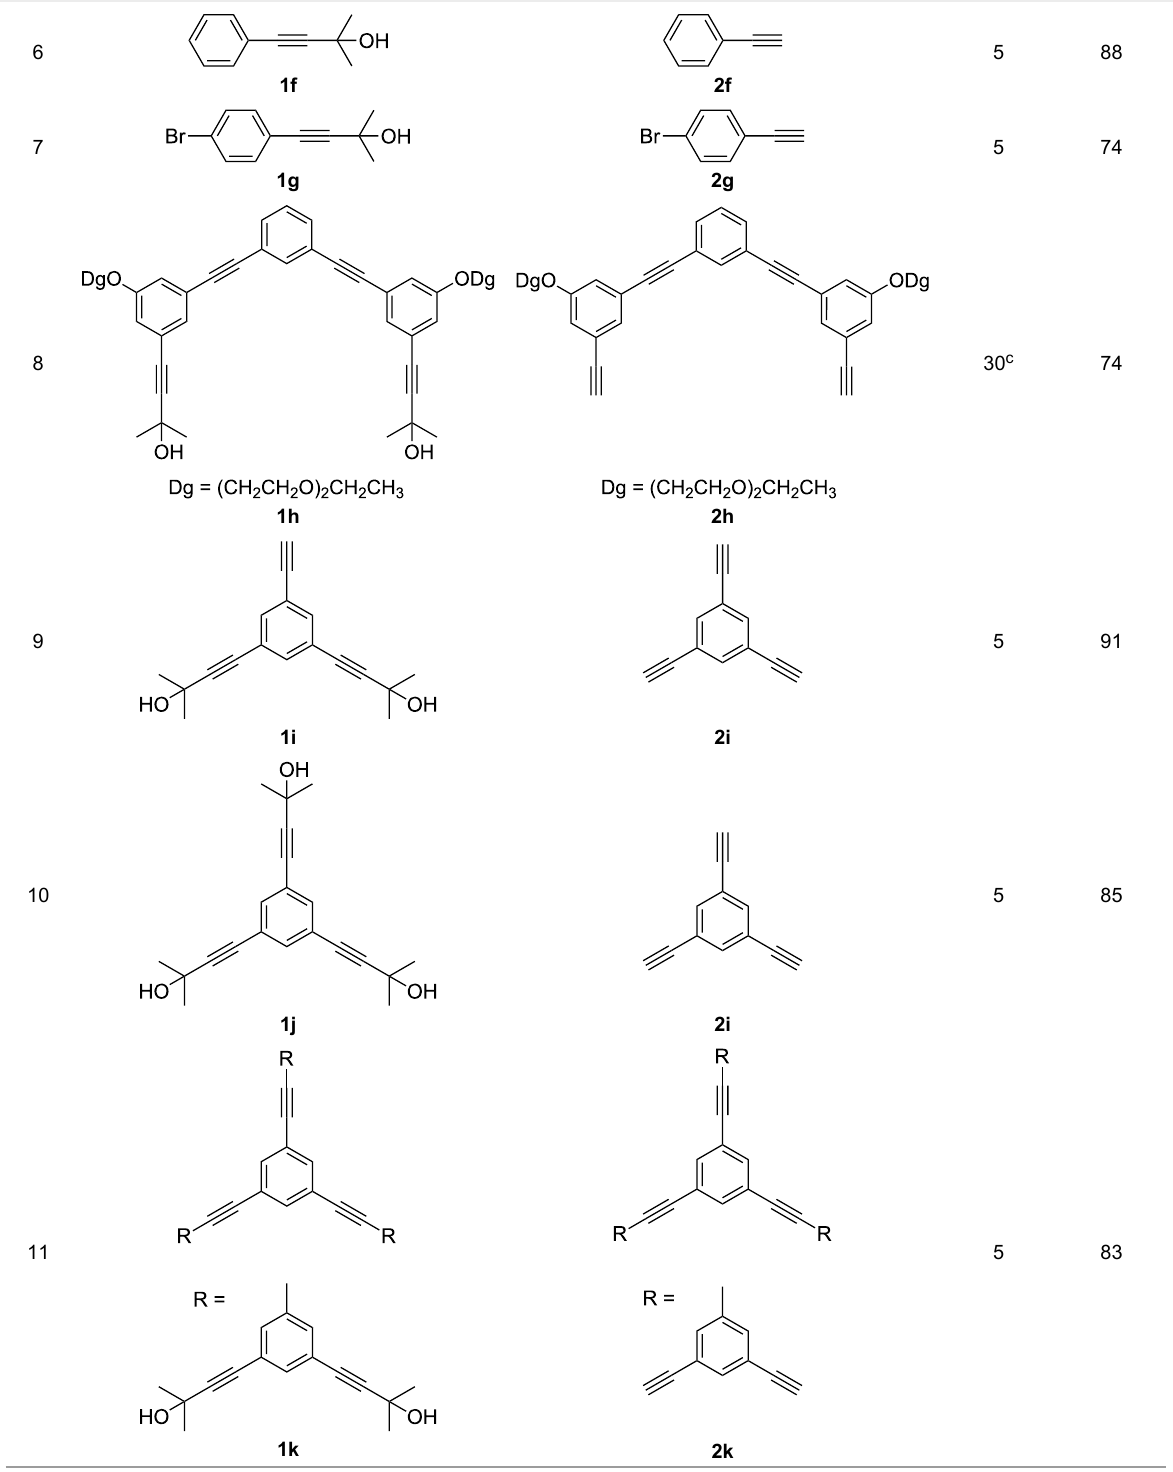
a Reaction conditions: 4-aryl-2-methyl-3-butyn-2-ol (2 mmol), Bu 4 NOH (0.1 mol per 1 mol 2-hydroxypropyl group), CH 3 OH (1.2 mol per 1 mol 2-hydroxypropyl group) and toluene (100 mL) under a N 2 atmosphere. b Isolated yields. c The reaction was carried out at 75 °C for 15 min, then at 90 °C for 15